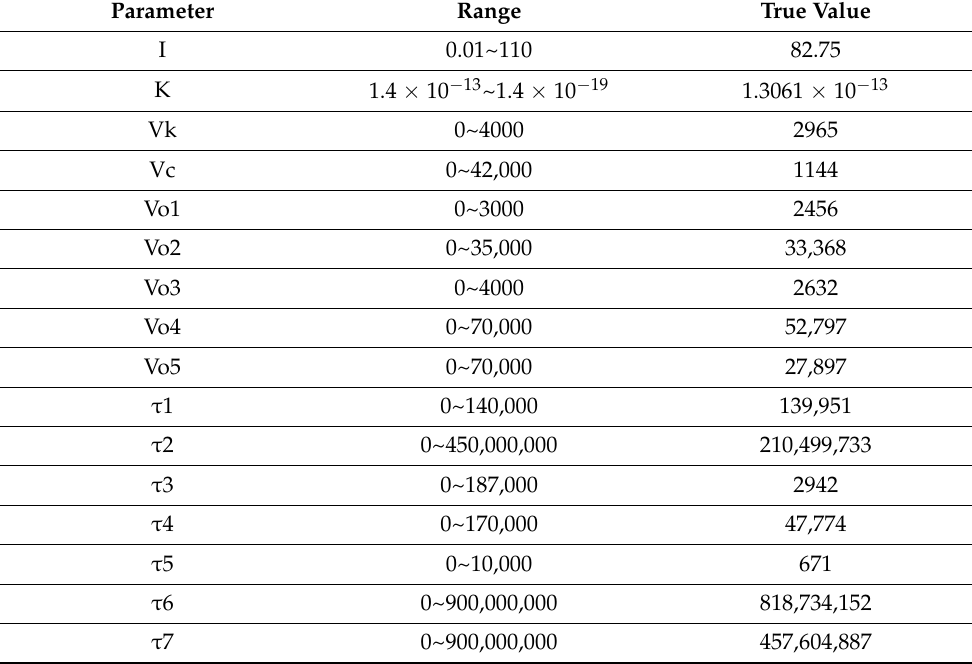
Table 8. The parameters of GA (S brand Table 8 . The parameters of GA (S brand 18650).